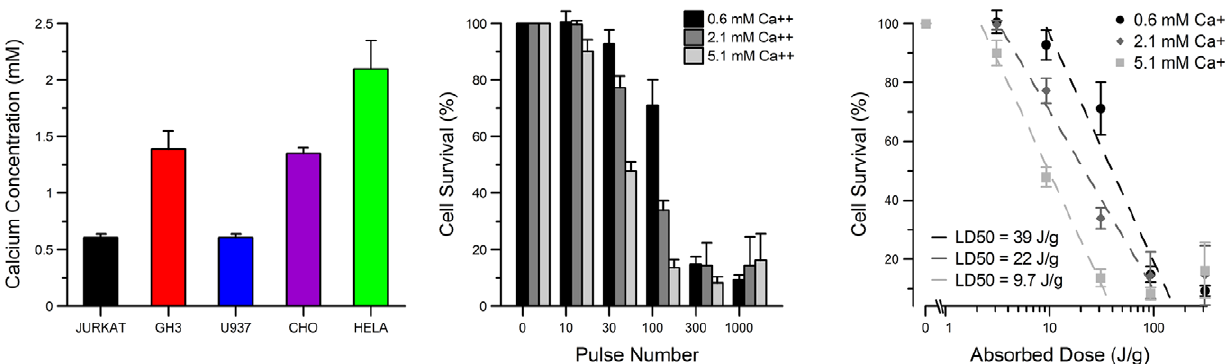
Figure 9. Differences in calcium concentration between different culture media are not responsible for differences in USEP-induced cell death. A: measured calcium concentrations in cell media. B: normalized 24-hr survival of Jurkat in media with modified Ca content. Increasing the external calcium has a negative effect on cell survival. C: a logarithmic fit to data by dose and the predicted LD 50 values. (mean + / 2 s.e, n=3).